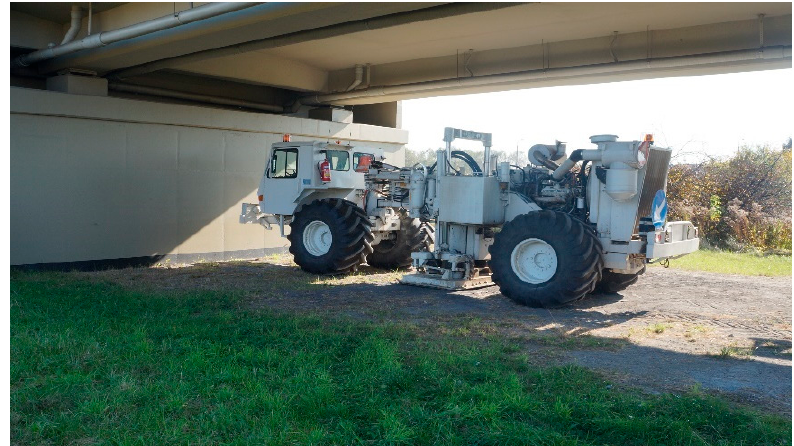
Figure 12. The Birdwagen MARK IV seismic vibrator during the in situ test [45].